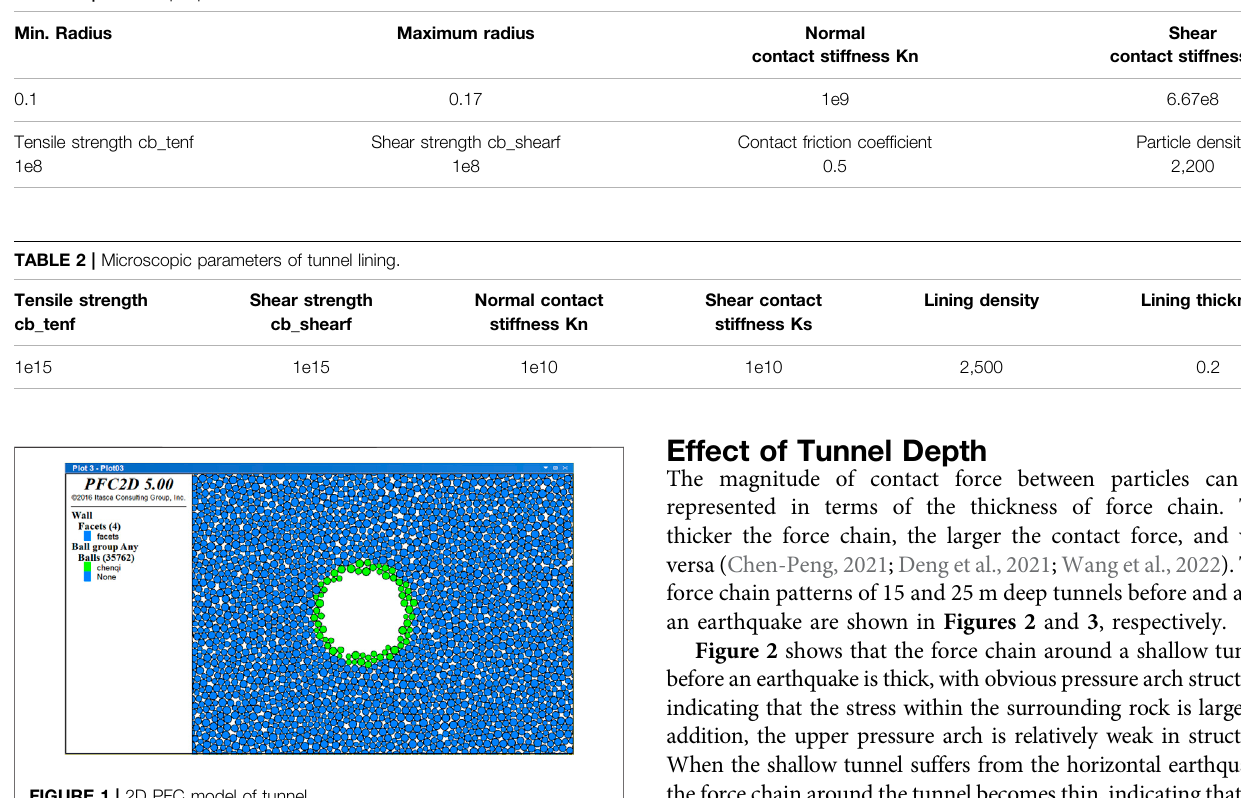
TABLE 1 | Microscopic parameters of soil.